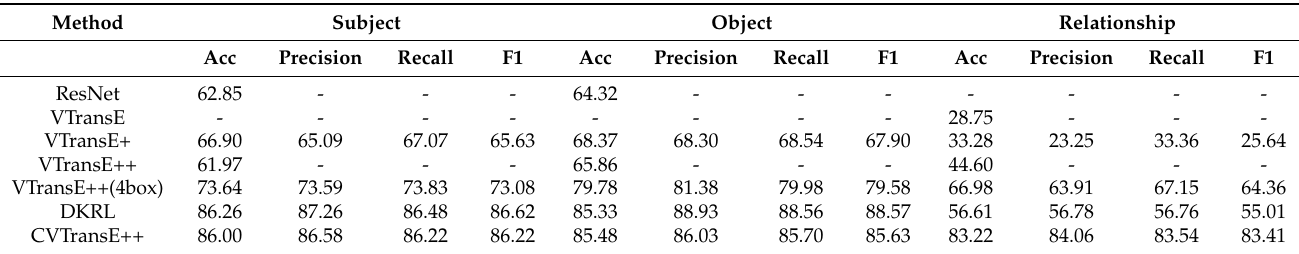
Table 2. Experimental